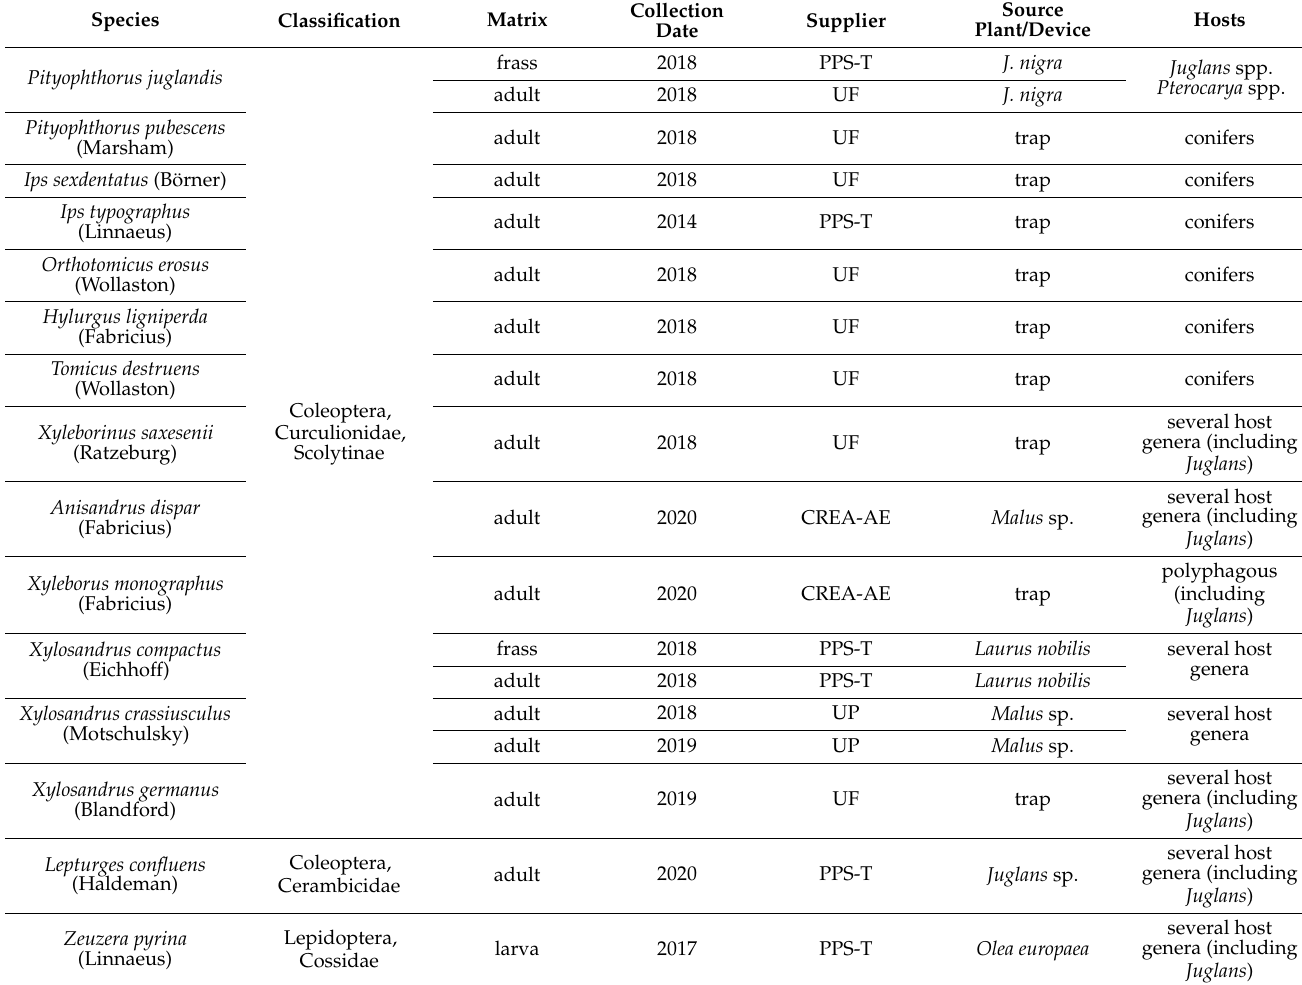
Table 2. List of target and non-target insects and biological material used in this study. PPS-T: Plant Protection Service of Tuscany, Laboratory of Phytopathological Diagnostics and Molecular Biology; UF: University of Florence; UP: University of Pisa; CREA-AE: Council for Agricultural Research and Economics-Agriculture and Environment